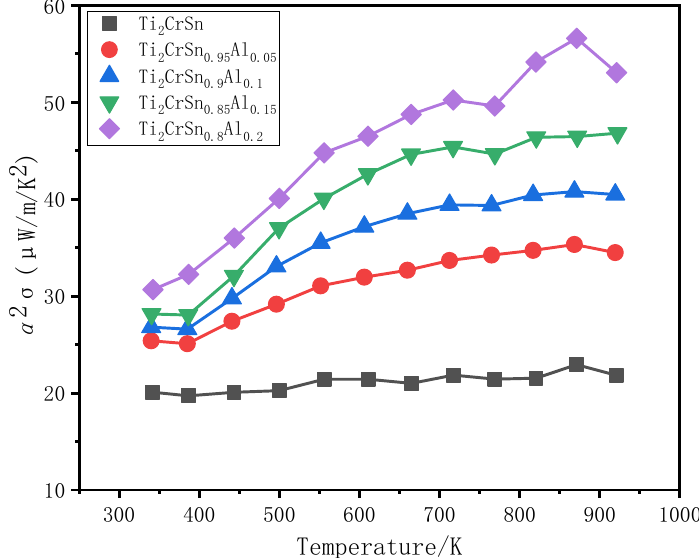
Figure 5. Power factor variation curve with temperature for the Ti 2 CrSn 1 − x Al x (x = 0, 0.05, 0.1, 0.15, 0.2) alloy.